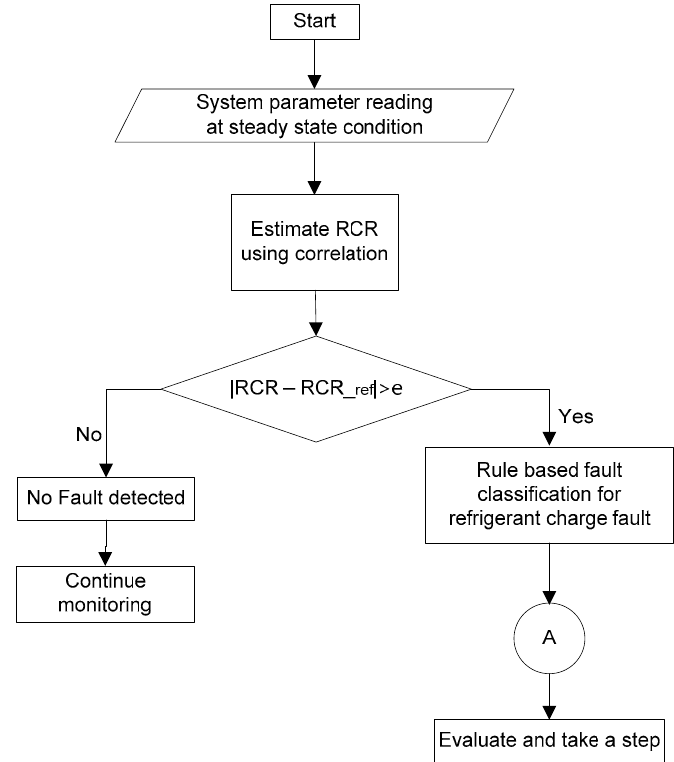
Figure 33.Figure 29. Refrigerant FDD algorithm for water-to-water heat pump unit. Figure 33. Refrigerant FDD algorithm for water-to-water heat pump